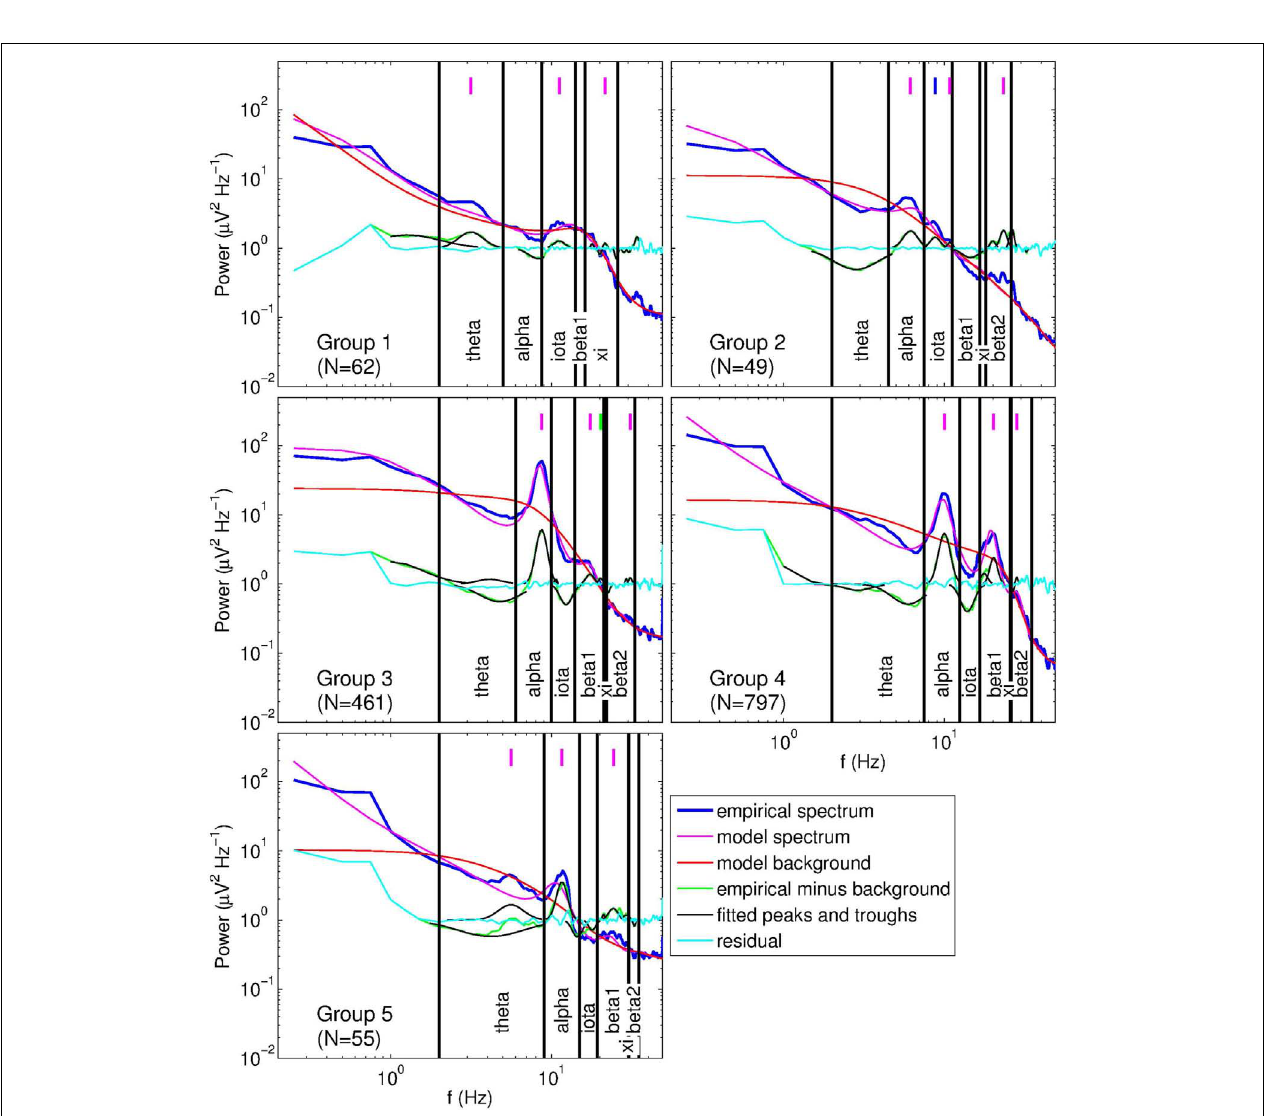
FIGURE 7 | Example spectra of subjects from each group having a different set of band limits, as listed inTable 1. Vertical lines indicate peak locations: magenta, primary peaks; blue, secondary alpha peak; green, secondary beta 1